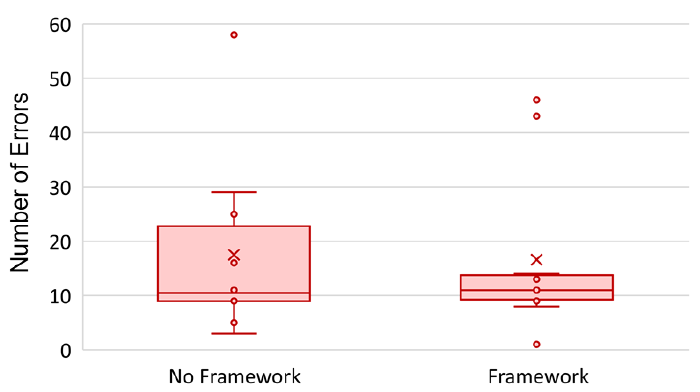
Figure 16. Summary of spent time to finish the application by the developers. Average of 4.82 h without the framework and 2.44 h with the framework.